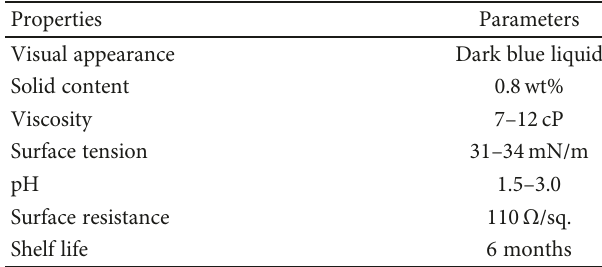
Table 2: Typical properties of PEDOT